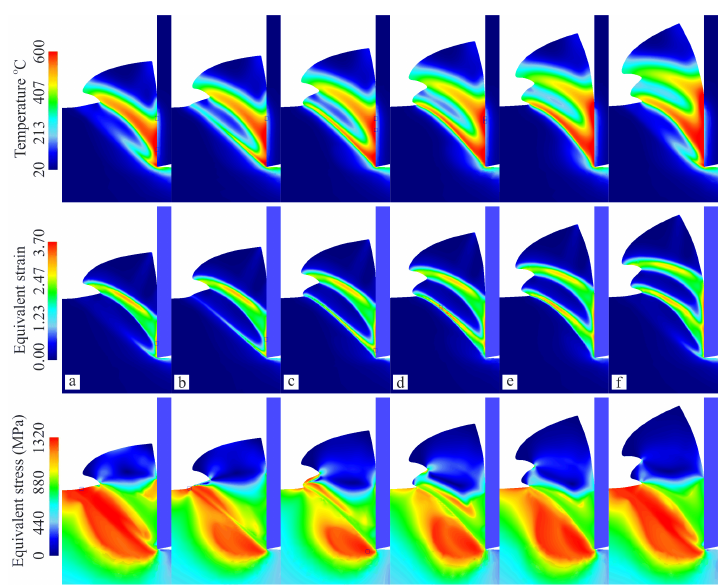
Figure 3. Temperature, equivalent strain ¯ (cid:101) and equivalent stress ¯ σ (von Mises) contours at different stages ( a – f ) of the ASB formation under thermally aided shear instability ( v = 200 m/min,